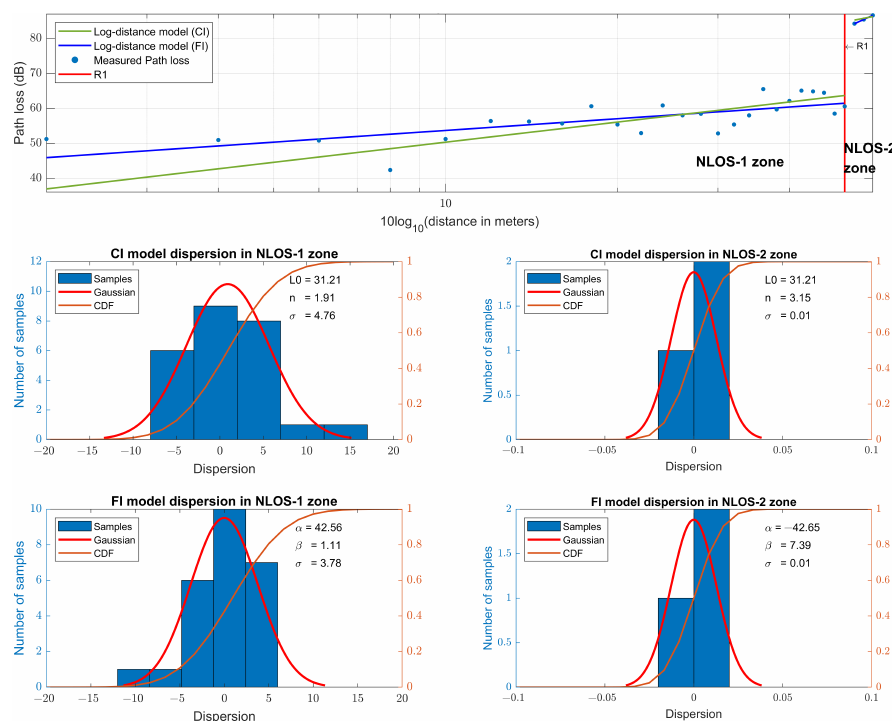
Figure 12. 5G SS-RSRP path loss models at 868 MHz and their